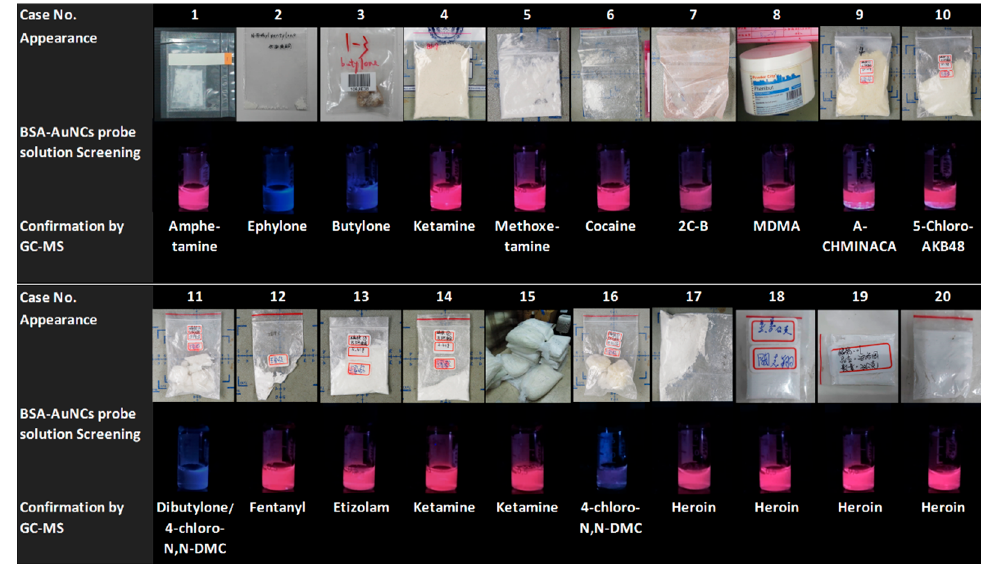
Figure 5. The appearance, the screening results by using this BSA-Au NCs probe solution, and confirmation by using GC–MS measurements of 20 actual cases from street and smuggling samples.